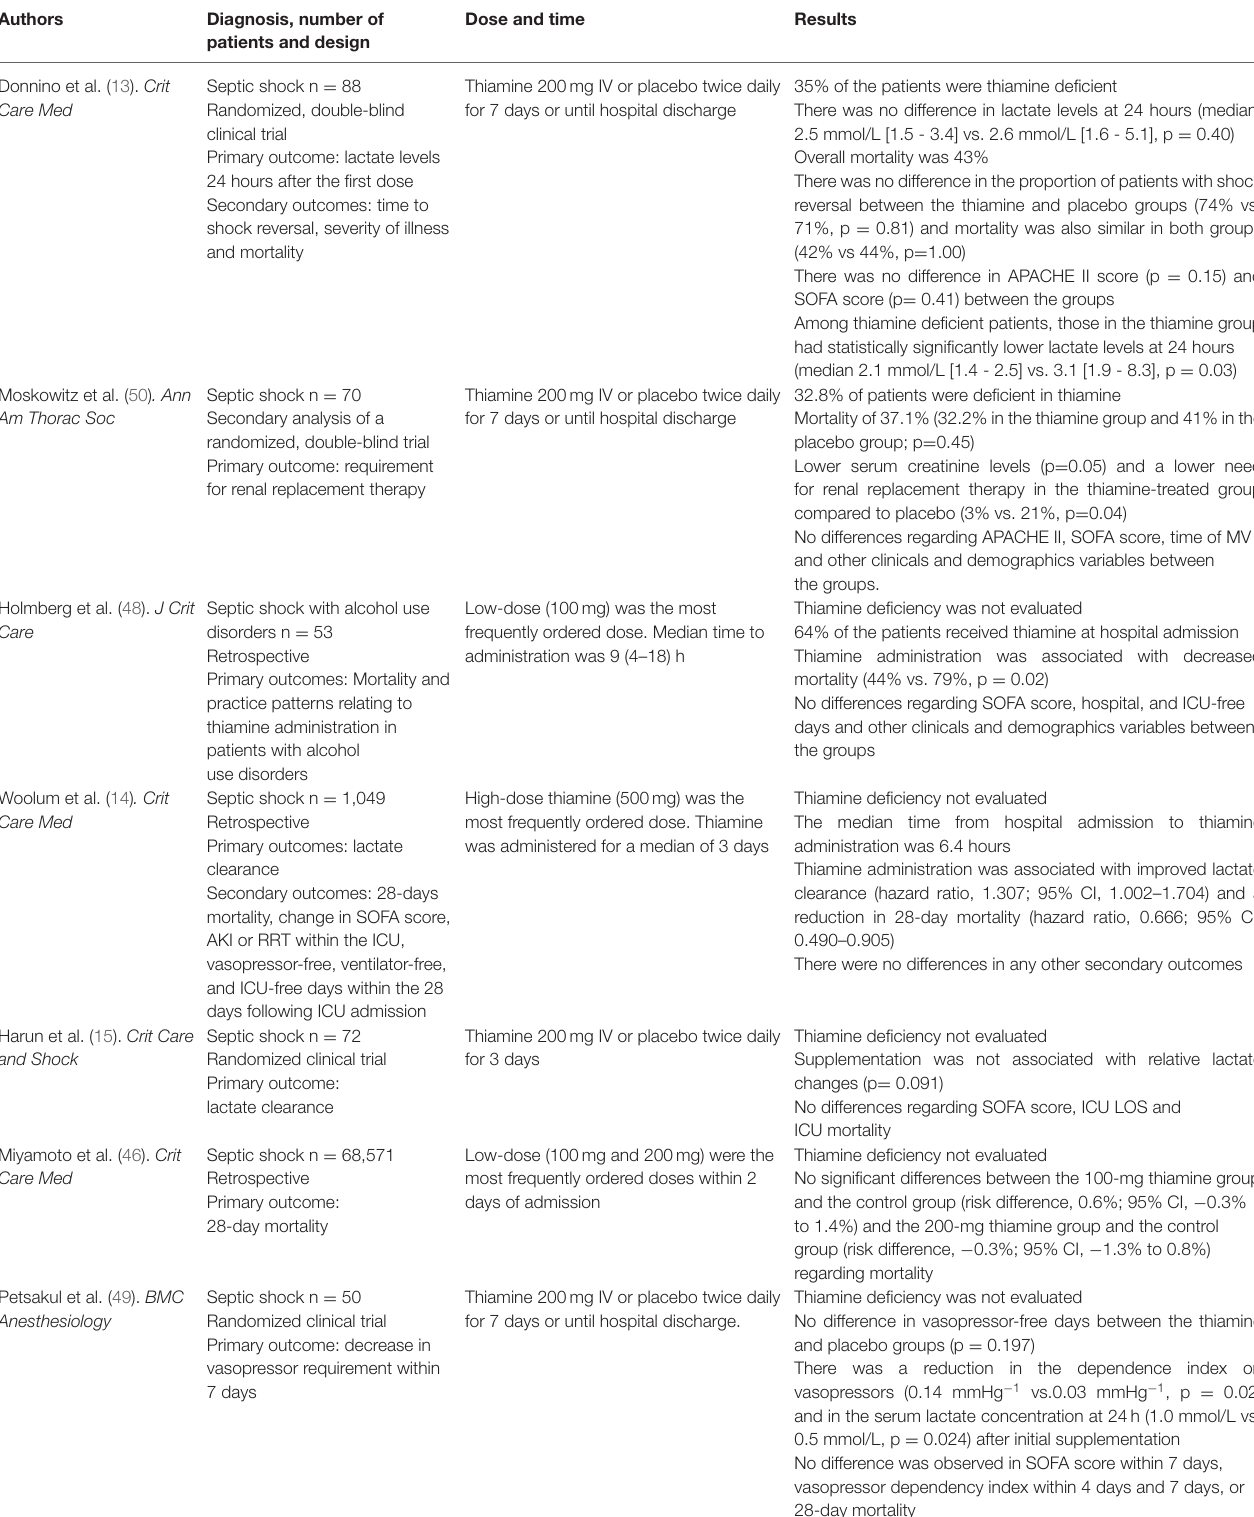
TABLE 1 | Clinical studies evaluating single thiamine supplementation in septic shock.